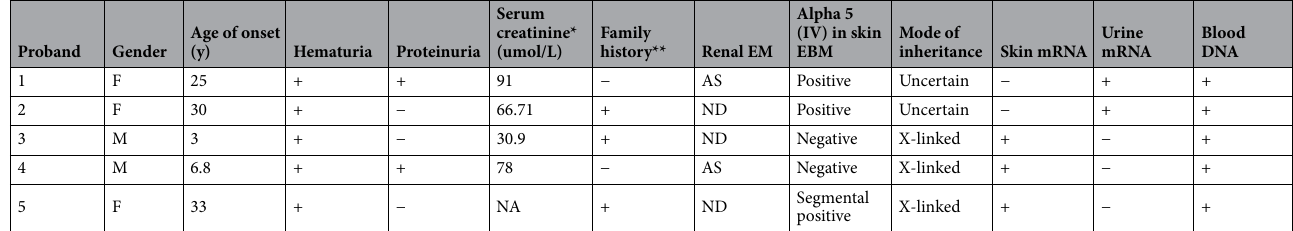
Table 1. Clinical features and analyzed samples of the 5 probands in this study. Patients 1 and 4 did not undergo staining of type IV collagen α5 chain in their renal specimen; hearing loss and ocular changes were not detected in five patients. *Age at which serum creatinine tests were carried out in the four probands was 25, 30, 10 and 14 years, respectively. **Positive family history of hematuria and/or end stage renal disease. EM electron microscopy, EBM epithelial basement membrane, NA not available, ND not done.